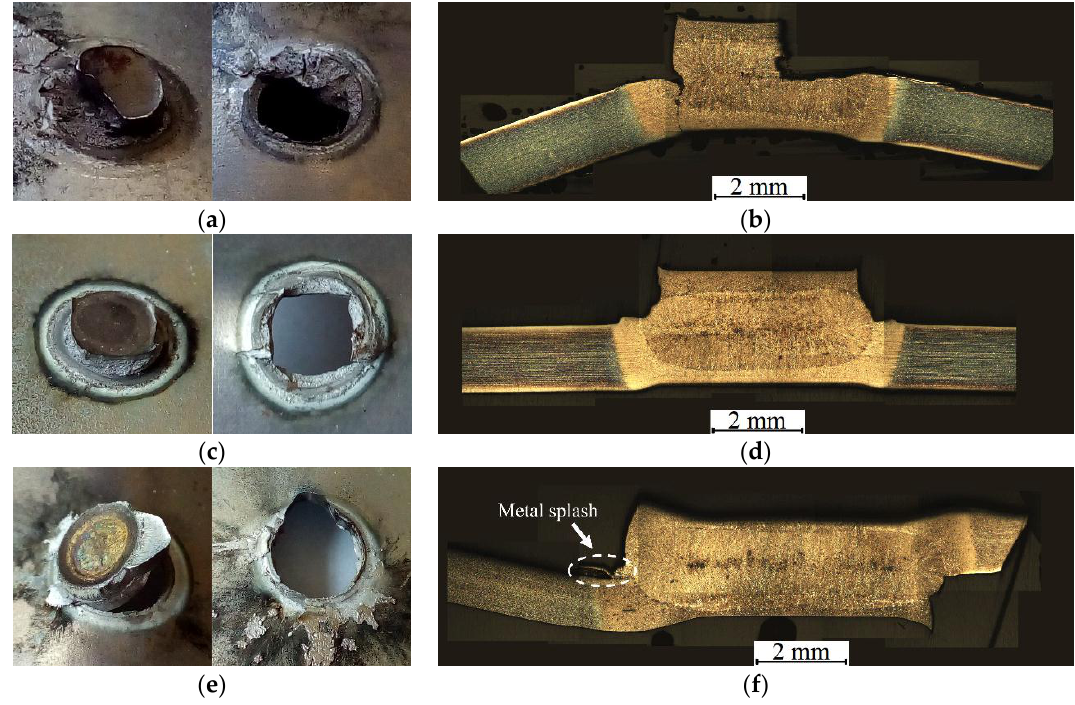
Figure 12. Modes of fractures of spot welds obtained after the cross tension tests, macroscopic and microscopic views. Typical fracture: ( a , b ) interfacial fracture with button pull; ( c , d ) partial dome fracture; and ( e , f ) button pull along nugget border and through HAZ steel sheet.